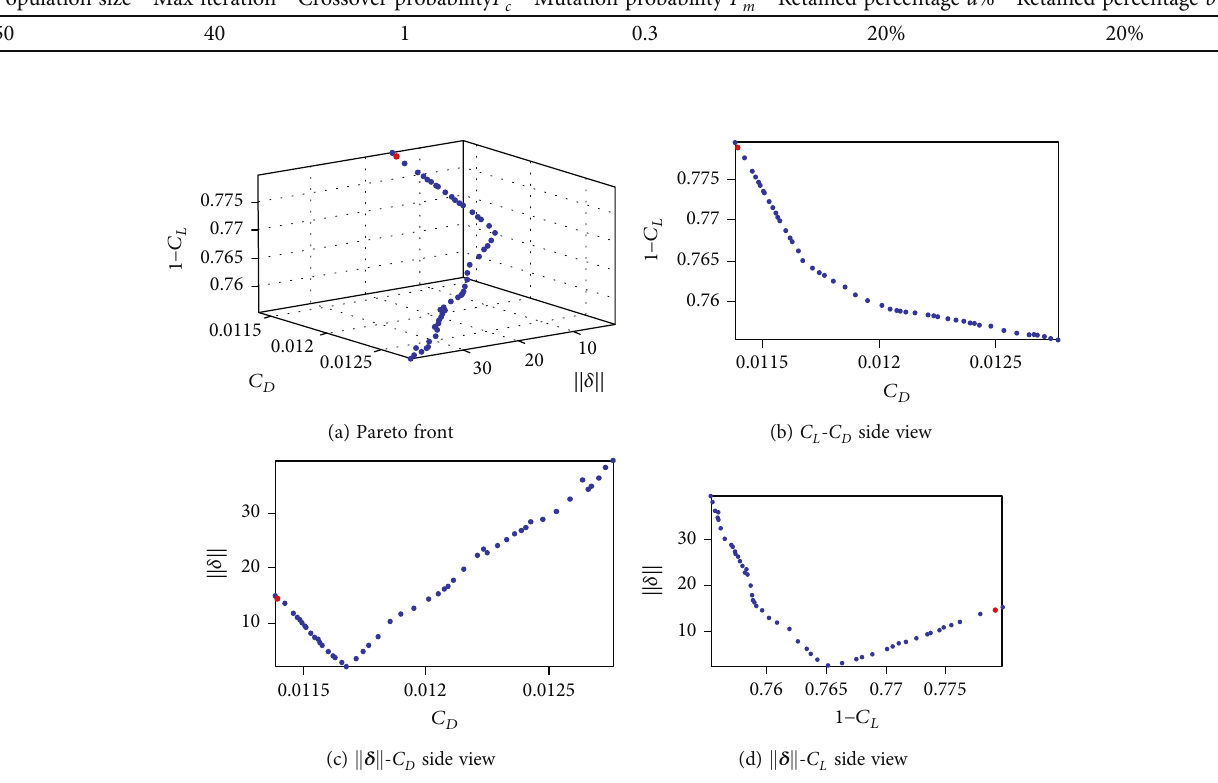
Figure 11: Pareto front and its side